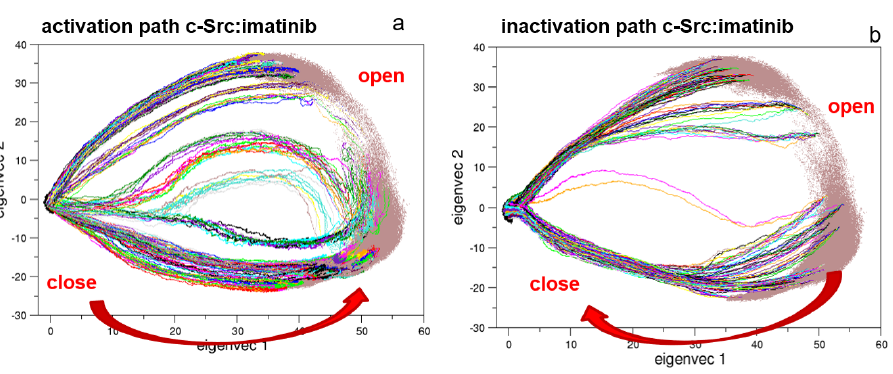
Figure 12. Projection along the first and second principal components of the EDS trajectories of c-Src bound to imatinib. In panels ( a , b ) are the projections of the 322 EDS trajectories describing the activation and the inactivation pathways, respectively.